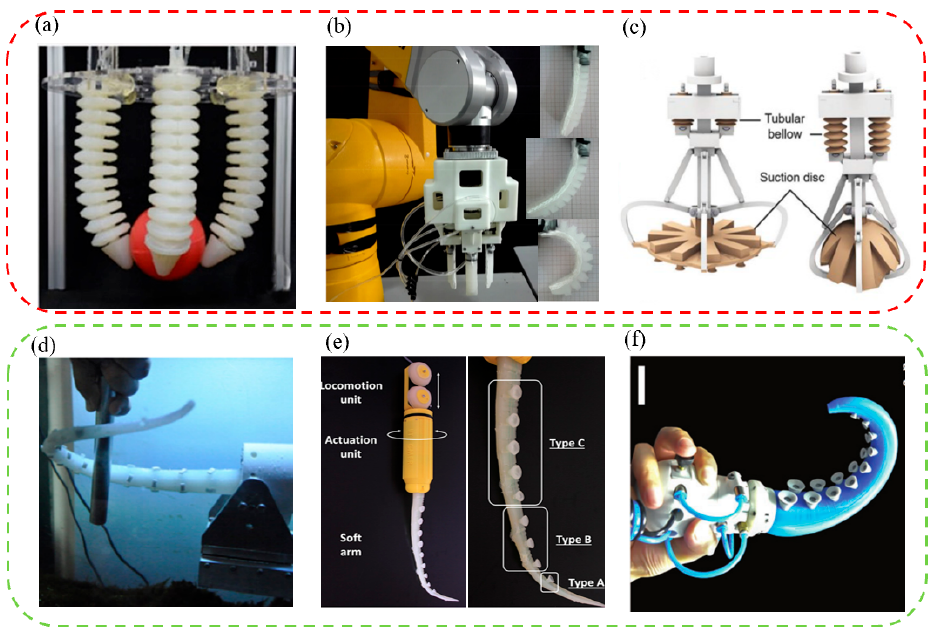
Figure 5. The bionic flexible grasping manipulators. ( a ) An adaptable grasping soft robotic arm which is actuated pneumatically (reproduced with permission from [122], The Chinese Society of Theoretical and Applied Mechanics, Copyright 2018). ( b ) A soft pneumatic dexterous gripper with convertible grasping modes (reproduced with permission from [123], Elsevier Ltd., Copyright 2019).